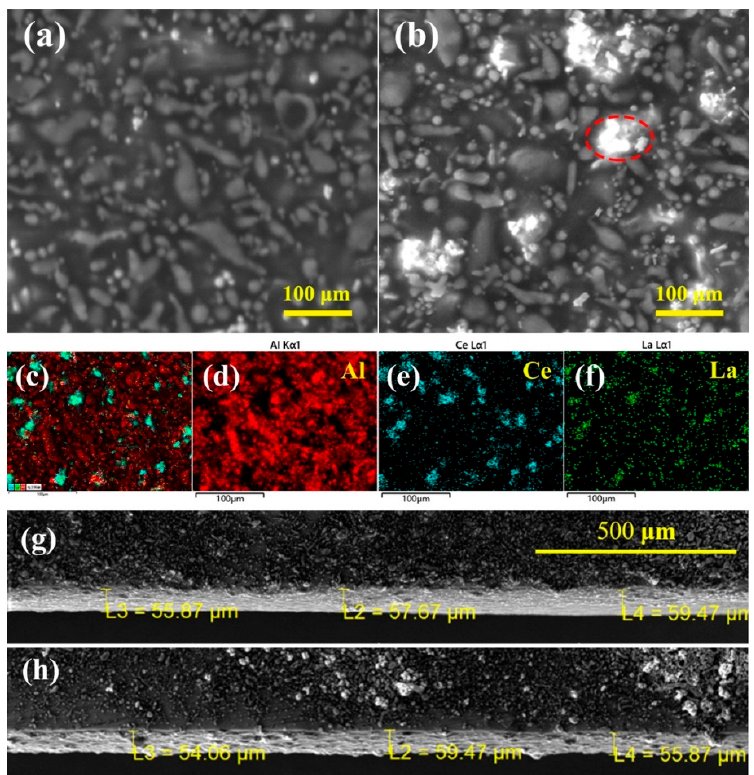
Figure 7. FESEM micrographs of ( a ) control coating, ( b ) 20% La-CeO 2 coating, ( c–f ) EDS mapping of 20% La-CeO 2 coating, cross-sectional view of ( g ) control coating and ( h ) 20% La-CeO 2 coating.